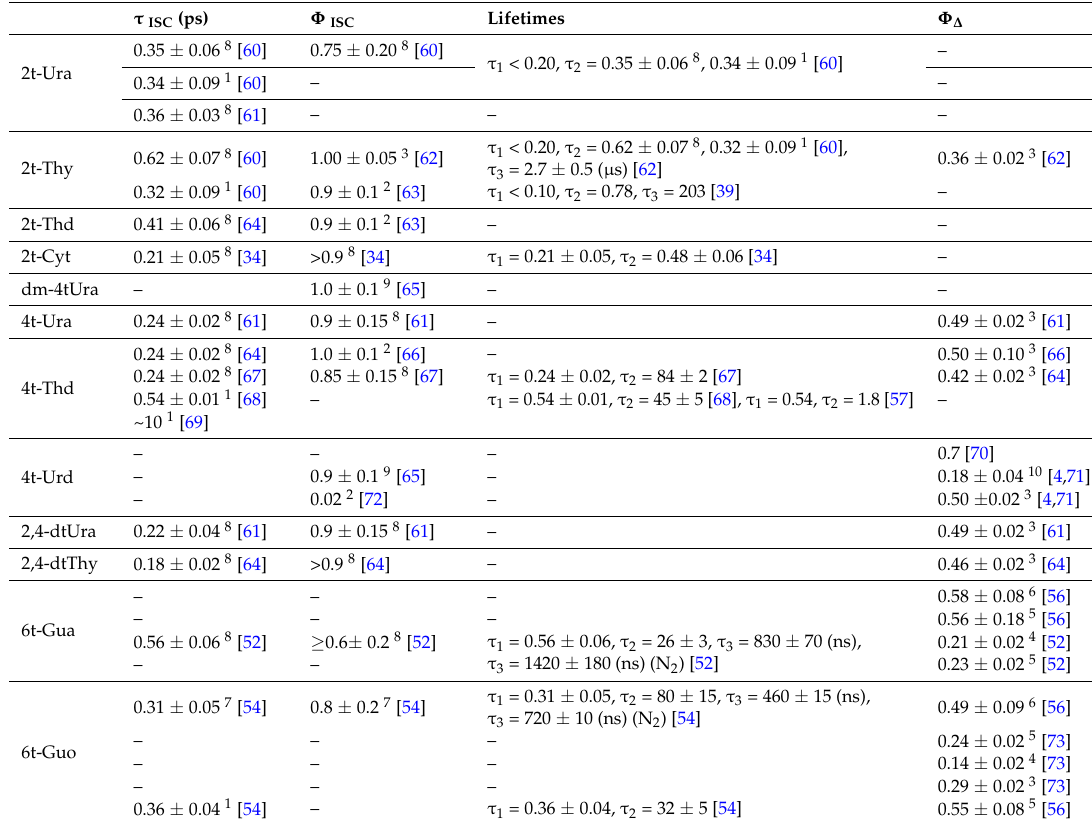
Table 3. Photophysical parameters (lifetimes in ps unless otherwise indicated and triplet and singlet oxygen quantum yields) for thiated nucleobase